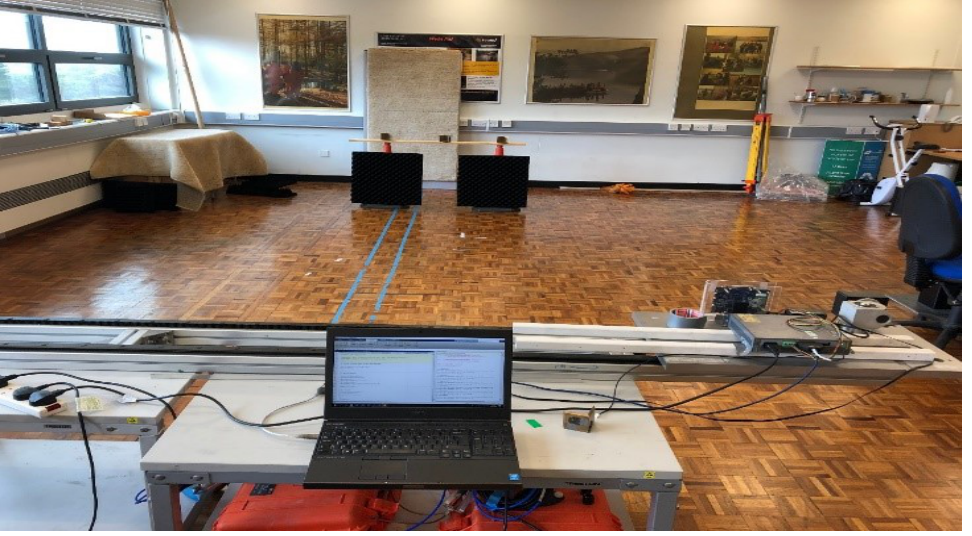
Figure 7. Experimental setup for the 24 GHz MIMO-SAR trial.